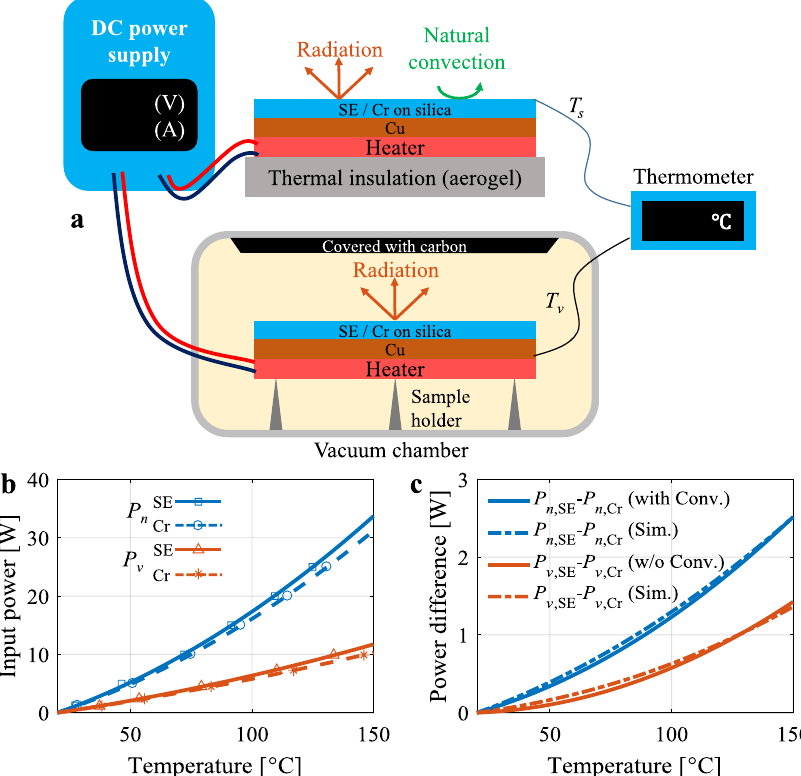
Fig. 4 Validation experiments of enhanced natural convection by radiation. a Schematic diagram showing a comparison of experimental setups between normal pressure and vacuum conditions. b The required input power for steady-state temperatures under normal pressure ( P n ) and vacuum ( P v ) conditions. c The input power difference between the SE and Cr at two conditions (with/without natural convection for normal pressure/vacuum) and simulated power differences with/without natural